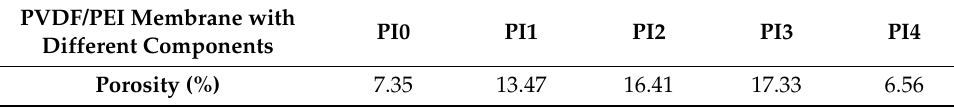
Table 5. Effect of PEI content on porosity.